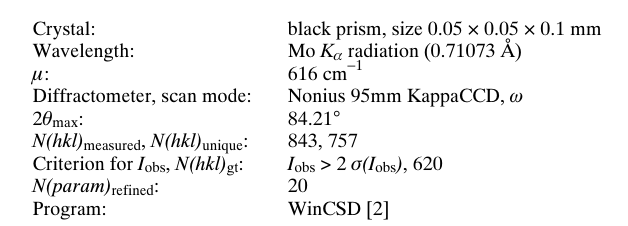
Table 1. Data collection and